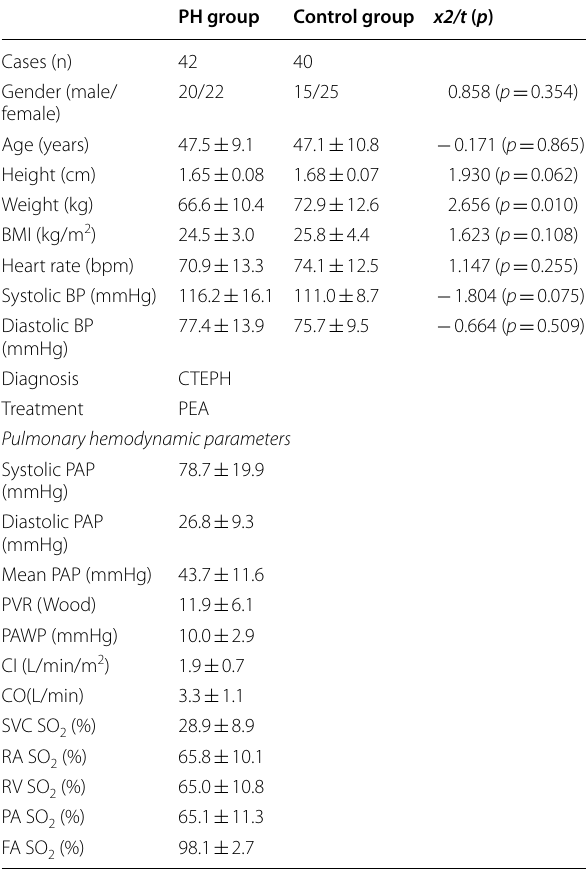
Table 1 Clinical information of patients with PH and the normal